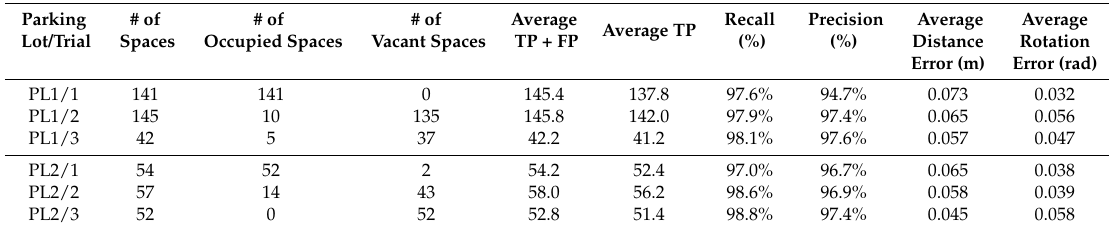
Table 3. Experiment result of parking space detection using proposed